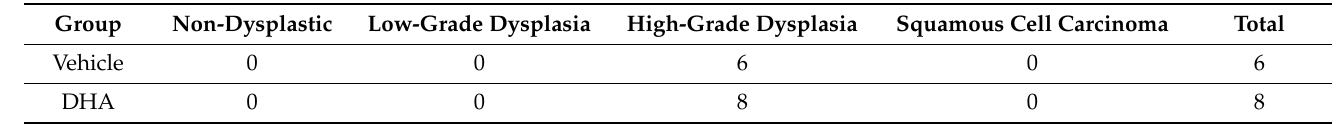
Table 2. Final anal histology after the treatment period in MmuPV1 anally infected mice. All mice had high-grade anal dysplasia upon final